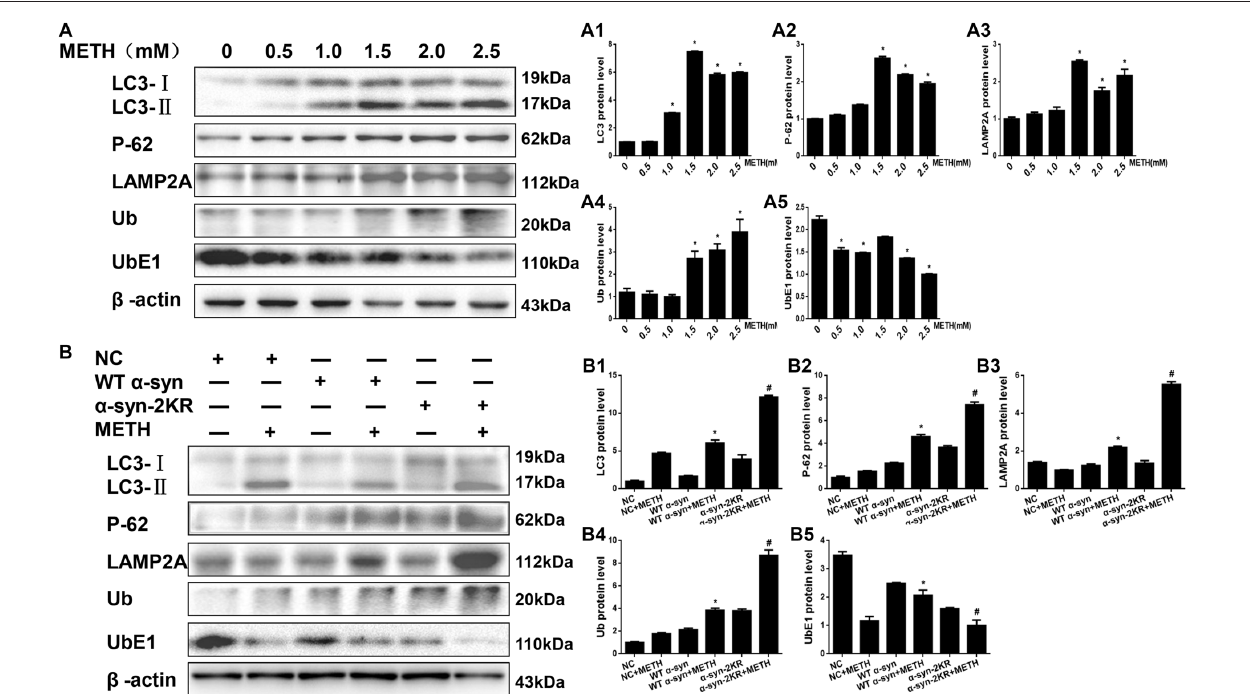
FIGURE 7 | Impaired SUMOylation of α -syn hinders α -syn degradation through the ubiquitin-proteasome system (UPS) and the autophagy-lysosome pathway (ALP). SH-SY5Y cells were exposed to METH in a dose-dependent manner for 24 h (A,A1–A5) . SH-SY5Y cells stably expressing GFP, WT α -syn or α -syn-2KR were treated with or without 2.0 mM METH for 24 h (B,B1–B5) . Western blot (A,B) and quantitative analyses (A1–A5,B1–B5) were performed to evaluate the expression of UbE1 and Ub, which are involved in the UPS, and of LC3-II, P-62 and Lysosomal associated membrane protein-2 (LAMP-2), which are involved in the ALP. β -Actin was used as a loading control. ∗ p < 0.05 compared with the control or LV-GFP group. # p < 0.05 compared with the METH-treated SH-SY5Y cells stably expressing WT α -syn. Data were analyzed using one-way ANOVA followed by LSD post hoc